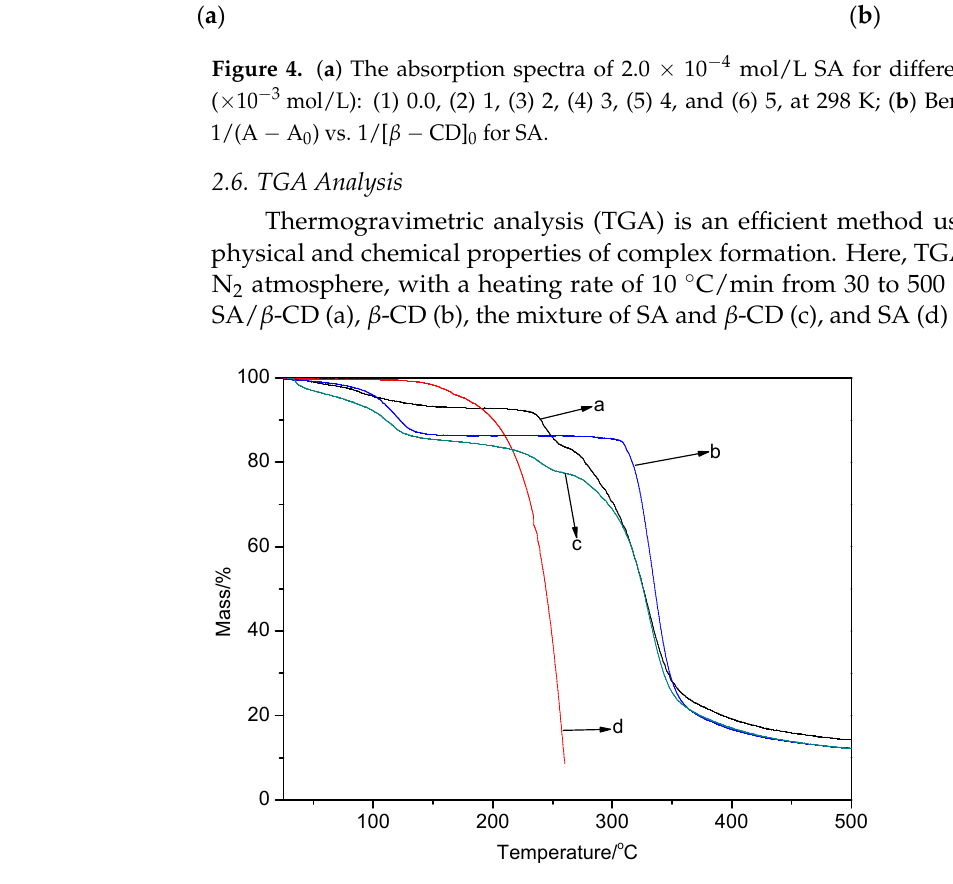
Figure 5. TG curves of: ( a ) SA/ β -CD complex, ( b ) β -CD, ( c ) physical mixture of SA and β -CD, and ( d ) SA.